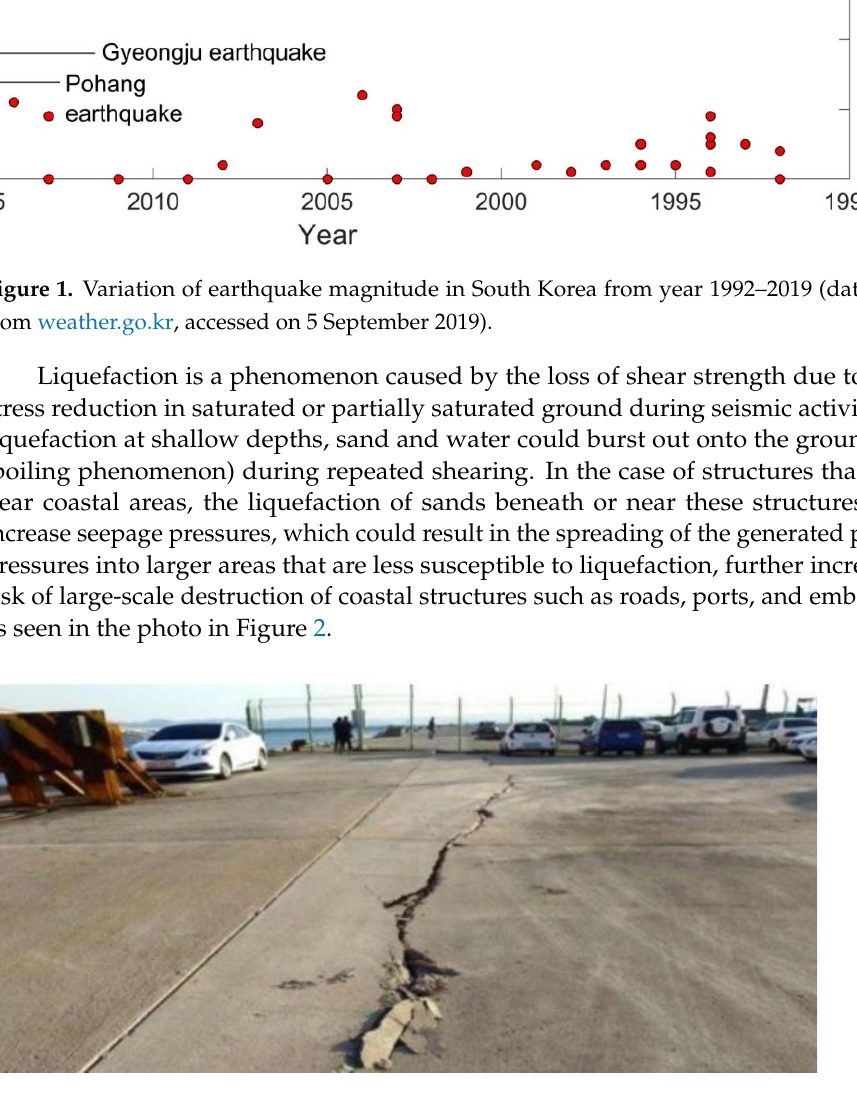
Figure 2. Cracks at a port in Pohang after the 5.4 magnitude Pohang earthquake hit the city (photo by the Ministry of Oceans and Fisheries of Korea).